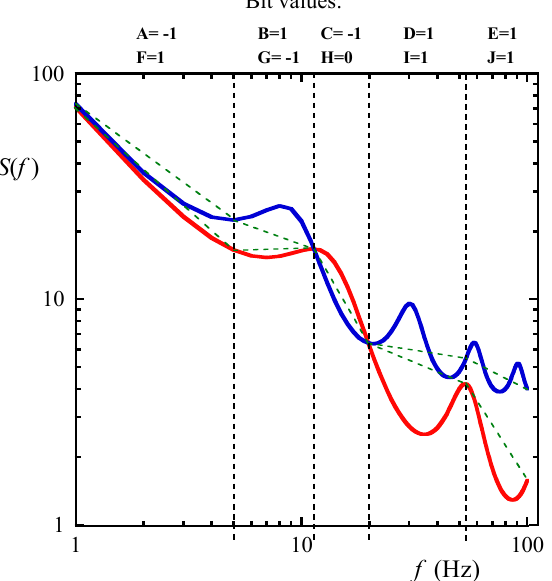
Figure 3. Generating the ternary fingerprints of the same PDS (blue solid line). The reference spectrum is shown with the red solid line. When the local slope of the spectrum (green dashed lines) is greater than the local slope of the reference spectrum (green dashed lines), the bit value is 1 (bits F, I, J). In the opposite case it is − 1 (bit G). When the slopes are equal, the bit value is zero (bit H). The binary fingerprints of the PDS are also shown (bits A–E).